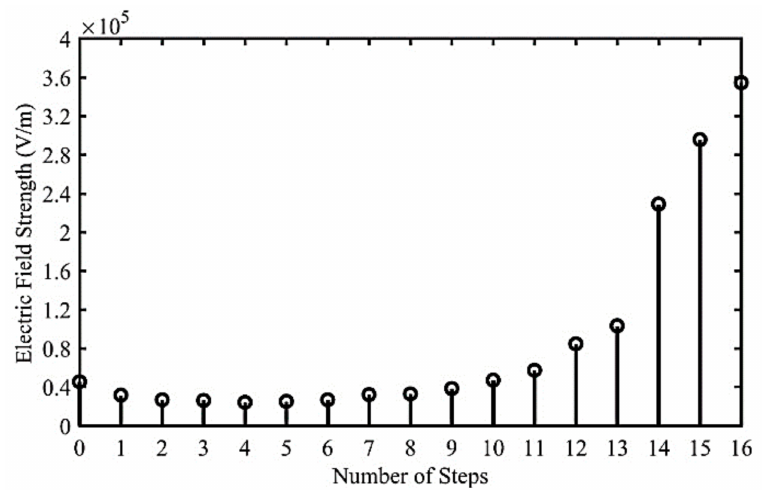
Figure 13. Line plot of laterite red bentonite.